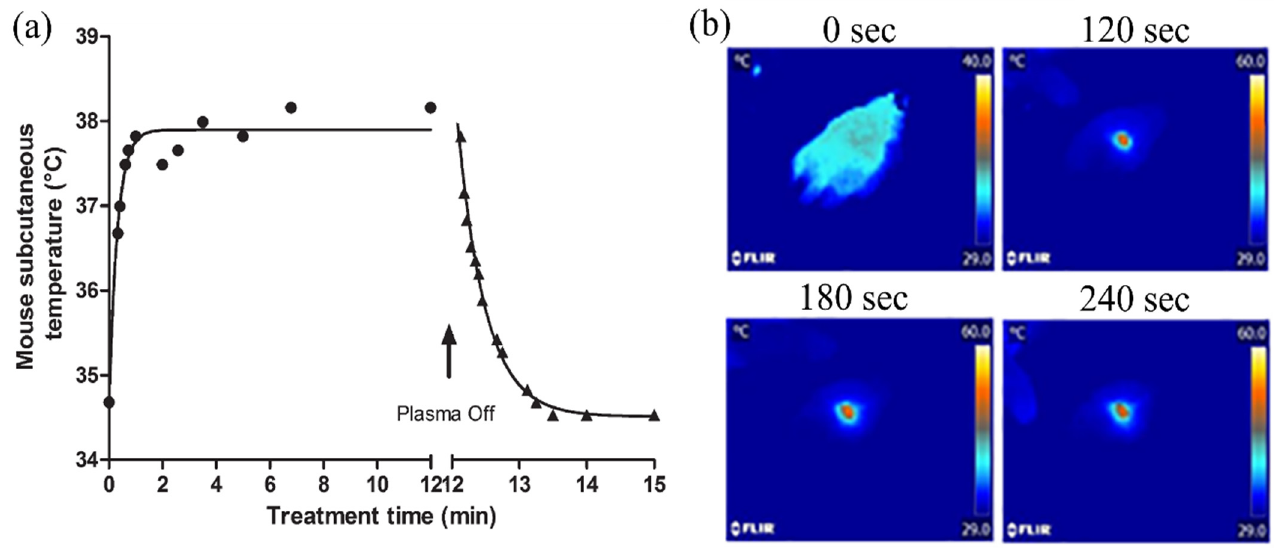
Figure 9. Thermal effect of CAP treatment on the mouse. ( a ) Evolution of mouse subcutaneous temperature during and after DBD treatment. Reprinted with permission from Ref. [53]. 2010, Wiley. ( b ) Temperature distribution infrared imaging on the APPJ-treated (4 min) mouse by a thermal visor [50].